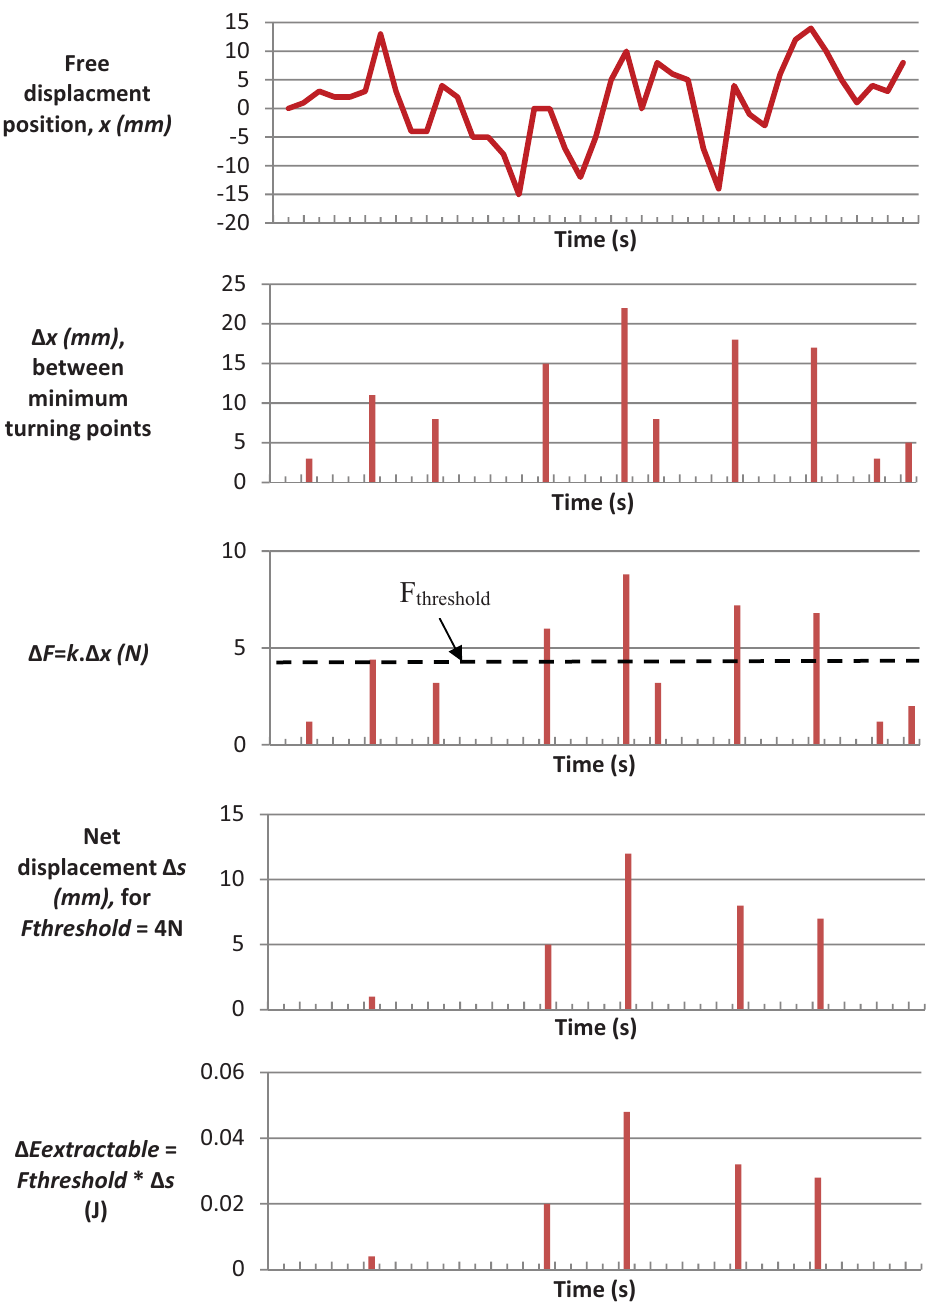
Figure 3. Example transformation from free displacement to extractable